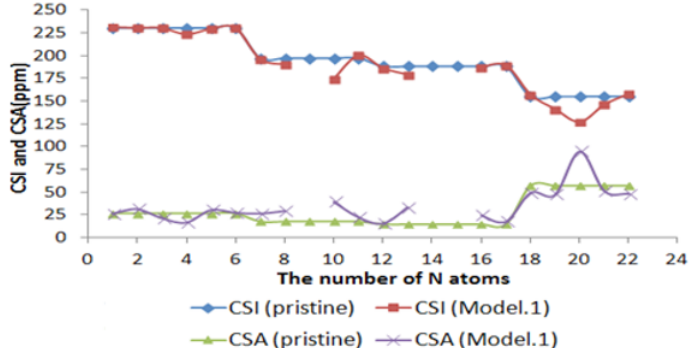
Figure 7. The NMR parameters for the 15 N atoms of O-decorated (10, 0) zigzag AlNNT